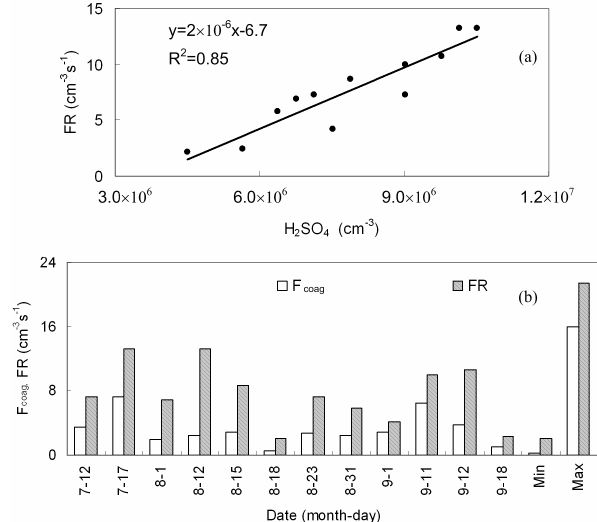
Fig. 2. Relationship of average formation rate (FR) and sulfuric acid concentration (a) and relationship of average coagulation loss ( F coag ) and formation rate (b) during NPF events. Min and Max are the minimum and maximum values from June through August from 2004 to 2008,